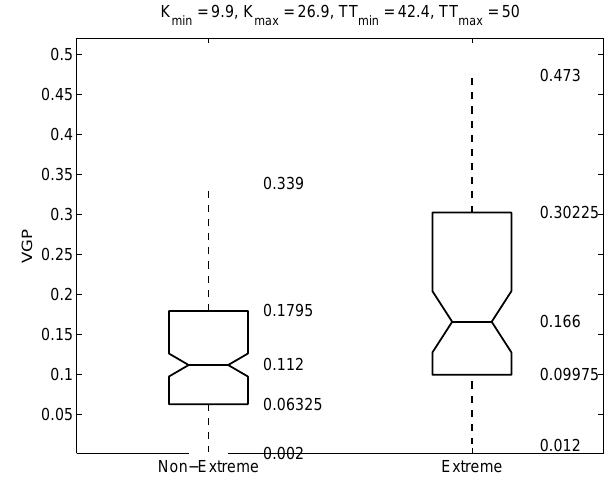
Fig. 9. Seasonal distribution of the potentially and observed ex- treme weather cases.